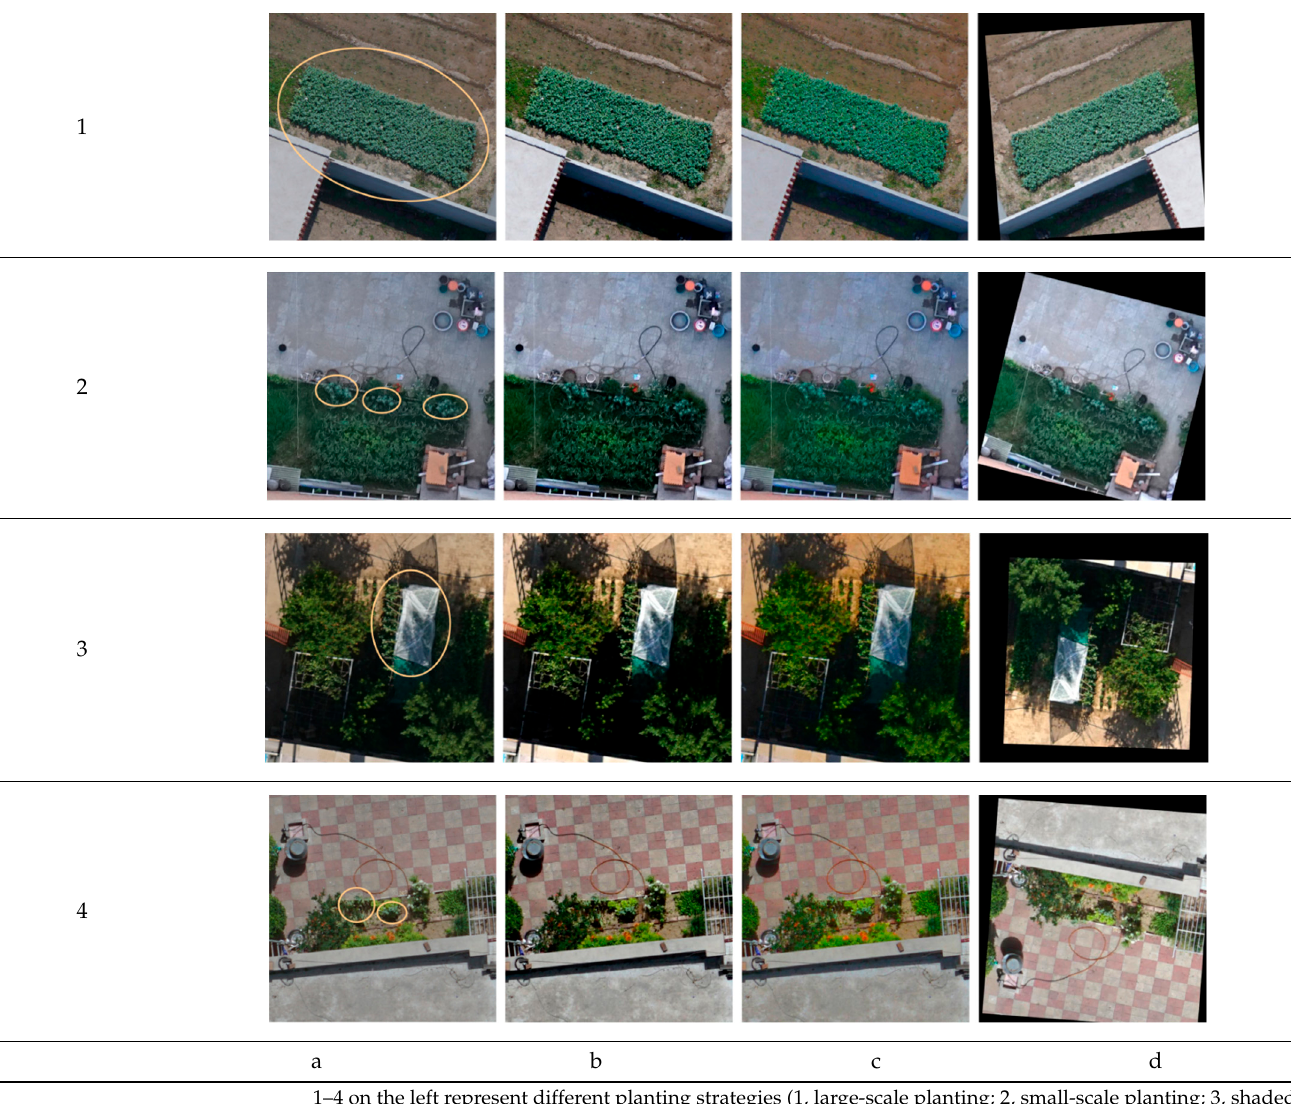
Table 2. Examples of preprocessed Papaver somniferum images for different planting strategies.